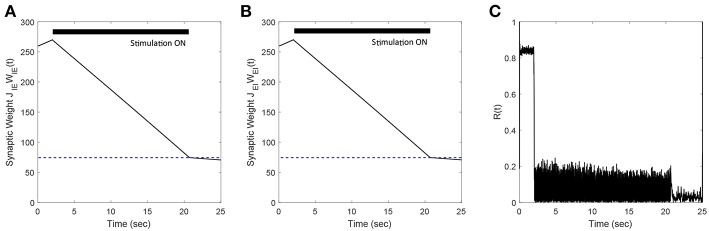
Efficacy of the FTSTS strategy in desynchronizing 2,000 neuron E-I network in the presence of Hebbian E-to-I and anti-Hebbian I-to-E plasticity. (A,B) Show the change in the average E-to-I and I-to-E synaptic weight of the network, respectively. (C) Shows the network synchrony level during the simulation. The FTSTS pulse parameters are Ustim = 100 mV, Tstim = 1 ms, and Tneutral = 10 ms.